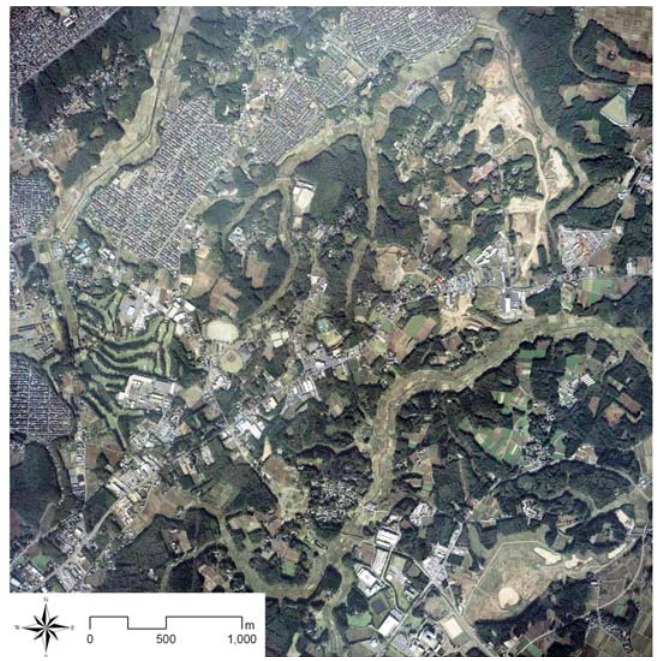
Figure 1. Typical mixed urban-rural land use landscape 30 km from central Tokyo. Residential areas and woodlands are located on the uplands and abandoned paddy fields in the narrow yatsu valleys that extend into the upland